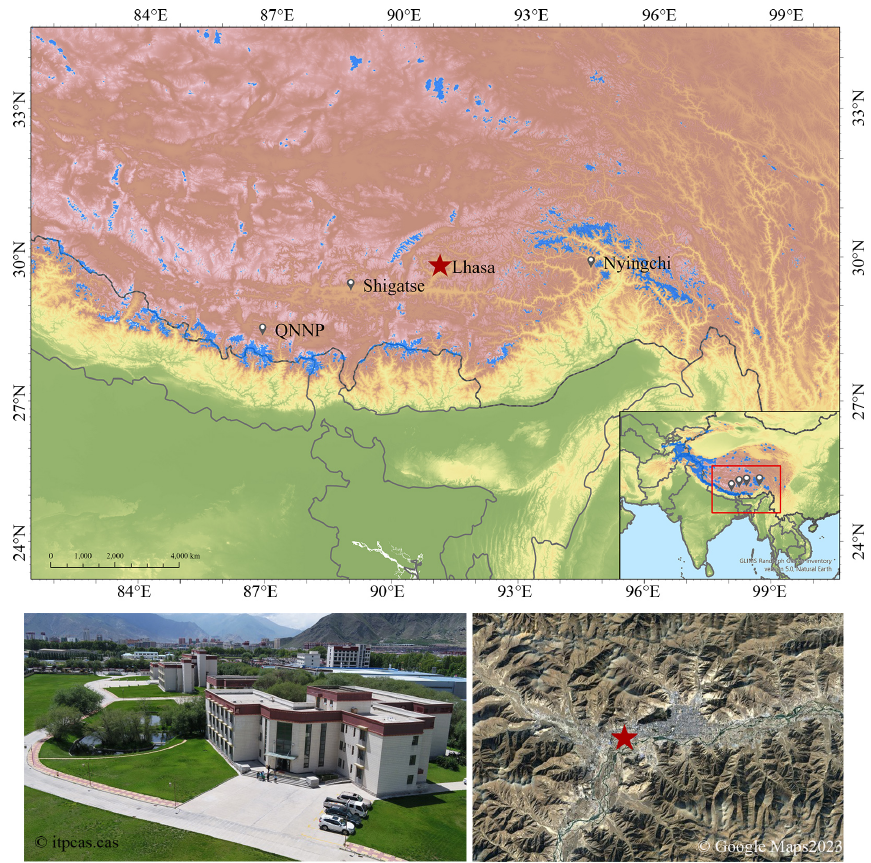
Figure 1. Location of the Lhasa station in the Institute of Tibetan Plateau Research, Chinese Academy of Sciences (red